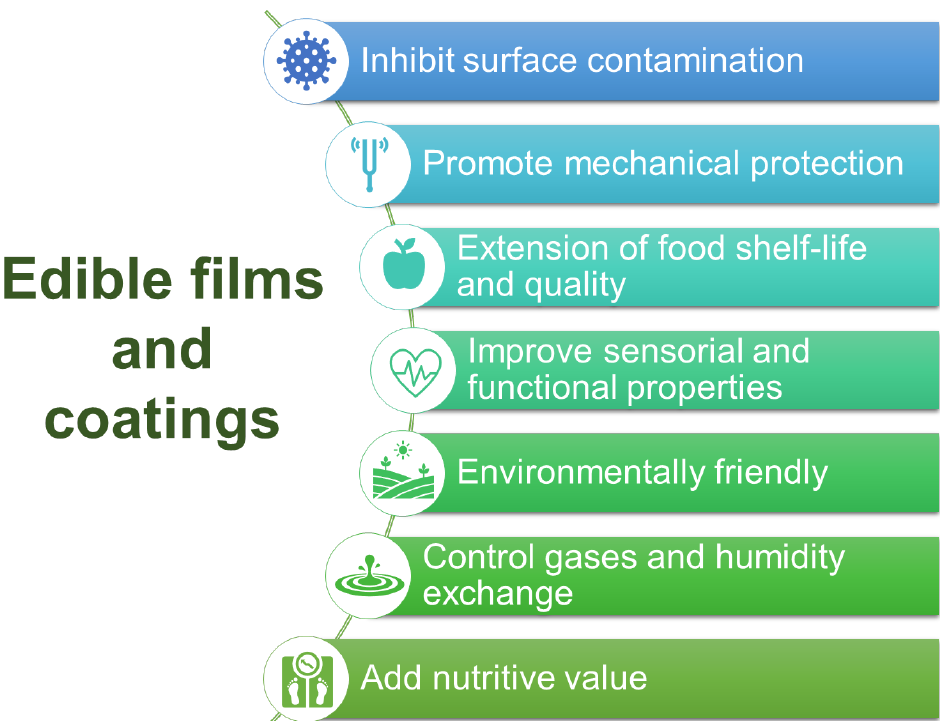
Figure 4. Main purposes of edible food packaging.